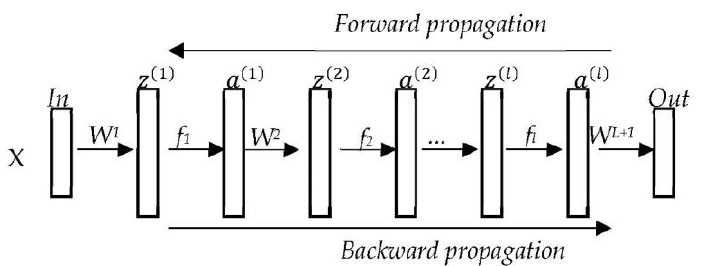
Figure 4. Schematic diagram of network propagation ( W i is the weight coefficient matrix, f i is the nonlinear activation function).